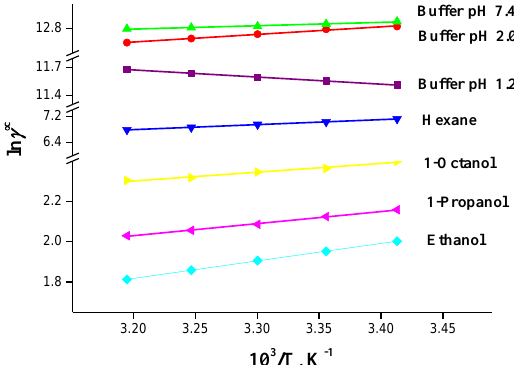
Figure 8. Temperature dependencies of activity coefficients at infinite dilution of IVZ in studied solvents. Table 7. Excess thermodynamic solubility functions of IVZ in studied solvents at 298.15 K and p = 101.3 kPa.